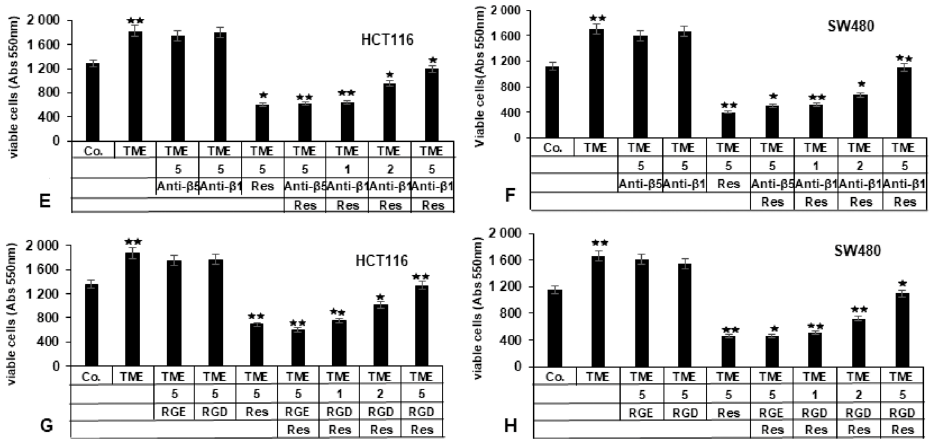
Figure 3. The importance of β 1-integrin for resveratrol-mediated down-modulation of tumor cell viability: ( A , B ) CRC cells (HCT116, SW480) from basal control (Co.) or TME control were not treated or treated with resveratrol (1, 5 µ M) in the presence or absence of IgG (1, 2, 5 µ g/mL), the blocking anti- β 1-integrin antibody (1, 2, 5 µ g/mL); ( C , D ) bacitracin (1, 5 µ M); ( E , F ) the blocking anti- β 1- integrin antibody (1, 2, 5 µ g/mL), anti- β 5-integrin (5 µ g/mL); ( G , H ) RGD peptide (1, 2, 5 µ M), RGE peptide (5 µ M) for 10–14 days. Tumor cell survival and, indirectly, proliferation were assessed by MTT assay. Relative to TME control, * p < 0.05 and ** p <